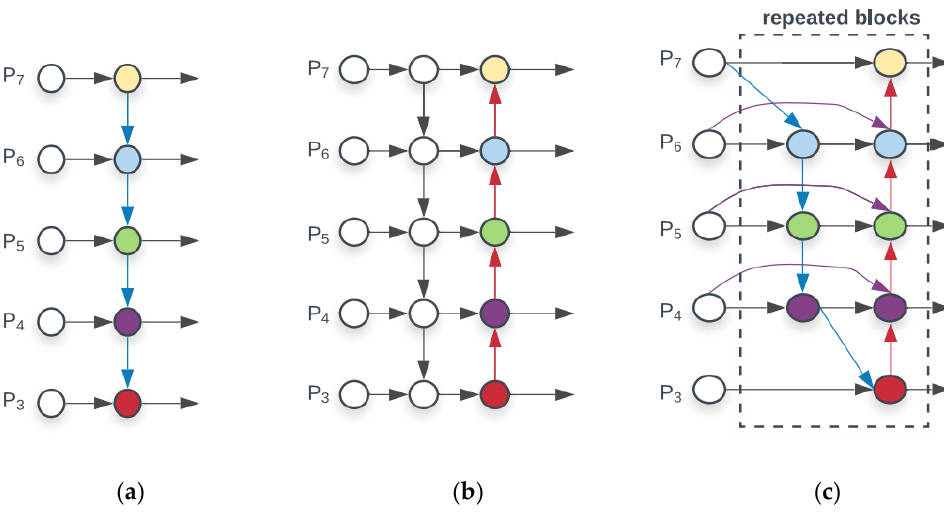
Figure 7. Schematic of the different feature fusion structures. ( a ) FPN; ( b ) PANet; and ( c ) BiFPN.